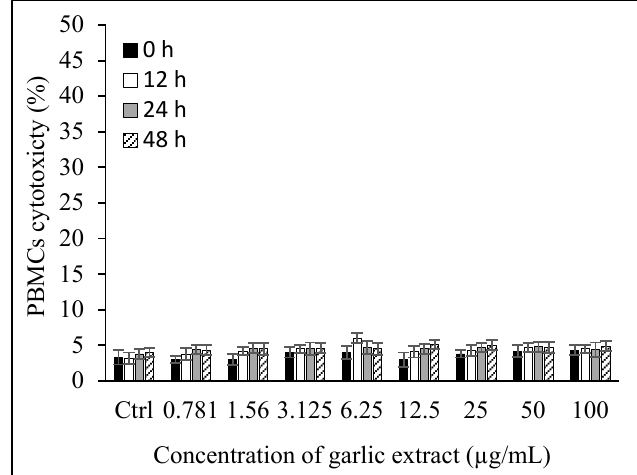
Figure 4. Freshly isolated PBMCs were incubated with different concentrations of garlic extract